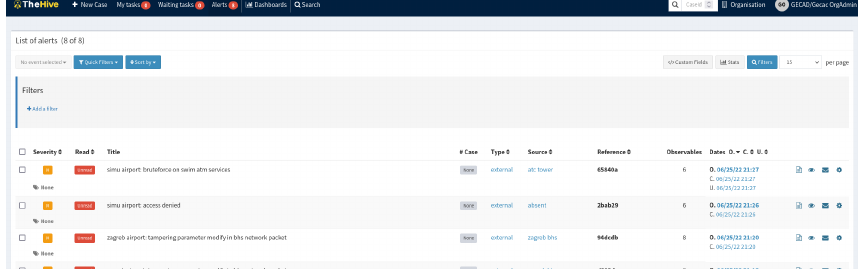
Figure 22. TheHive Alert Queue.